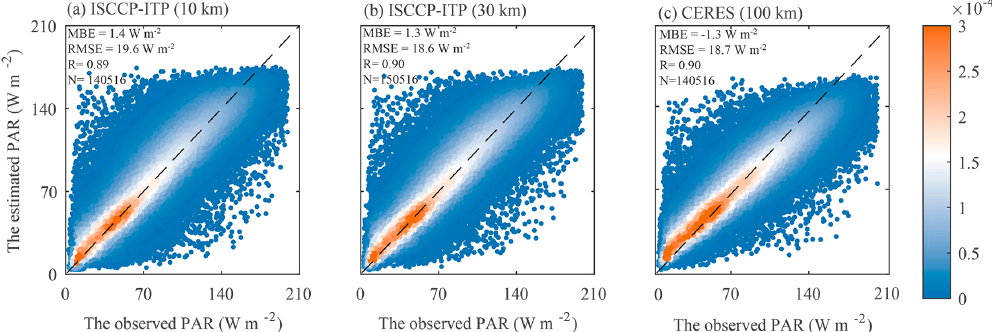
Figure 8. Comparisons of our estimated daily PAR product (ISCCP-ITP) at spatial resolutions of (a) 10km, (b) 30km, and (c) daily PAR of the CERES SYN1deg (edition 4.1) with observed PAR collected at 38 CERN stations.